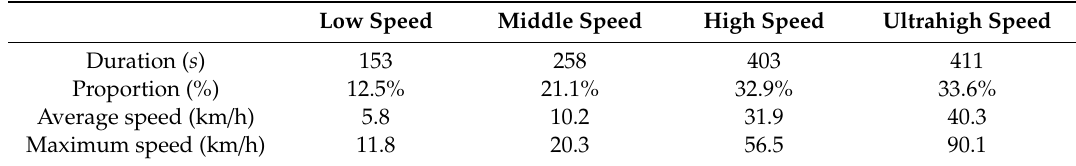
Table 4. Length of each speed state and its